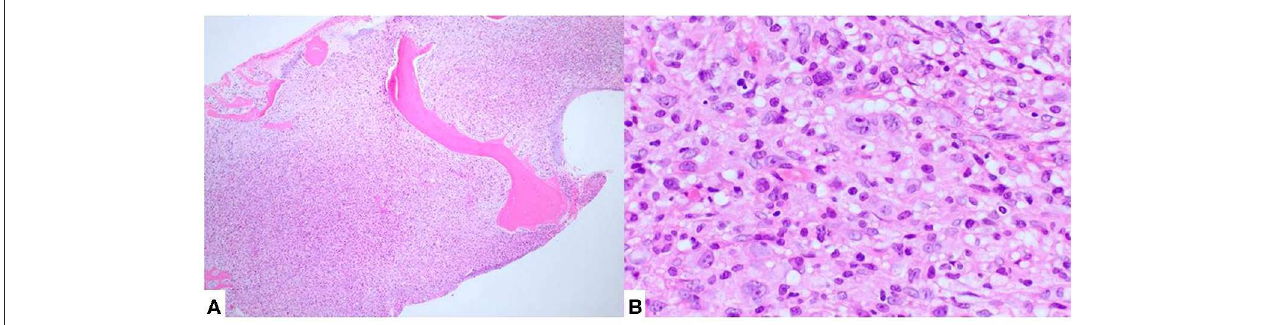
FIGURE 3 | Bone marrow biopsy showed diffuse involvement by lymphoma (A) . Atypical cells, morphologically similar to those seen in the lymph node biopsy, were also present (B) .